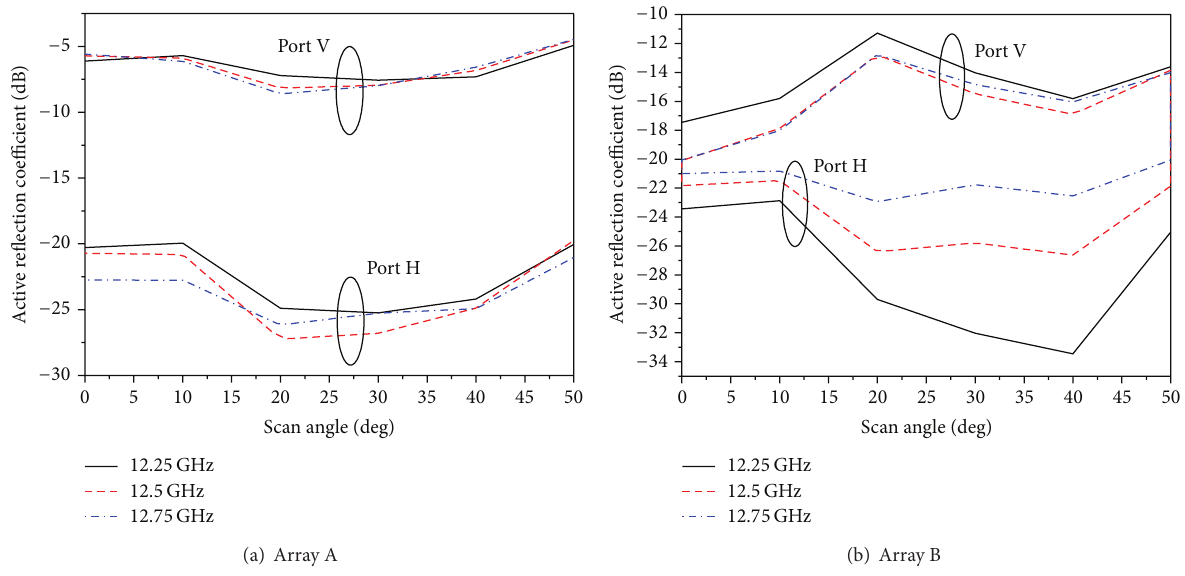
Figure 4: The active reflection coefficient of central element R5-3 (azimuth angle 𝜑 = 0 ∘ , vertical polarization).